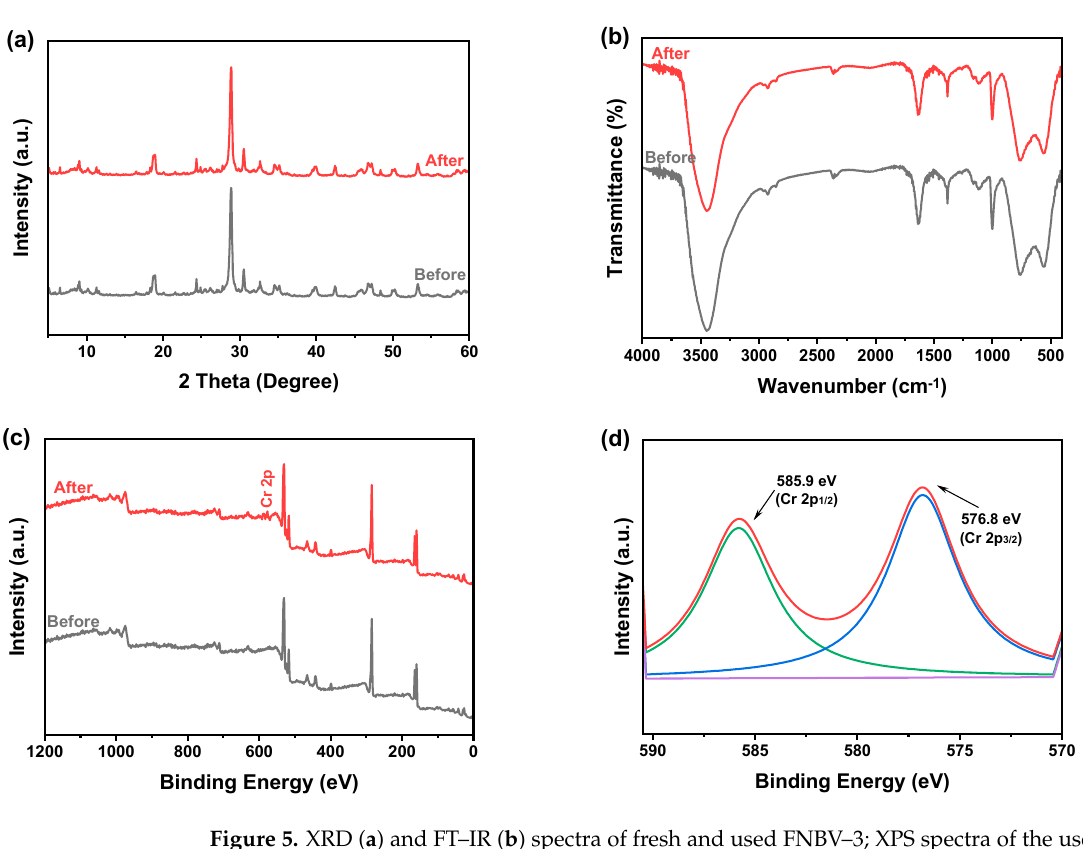
Figure 5. XRD ( a ) and FT–IR ( b ) spectra of fresh and used FNBV–3; XPS spectra of the used FNBV–3 samples; ( c ) survey scan; ( d ) Cr 2p spectra.